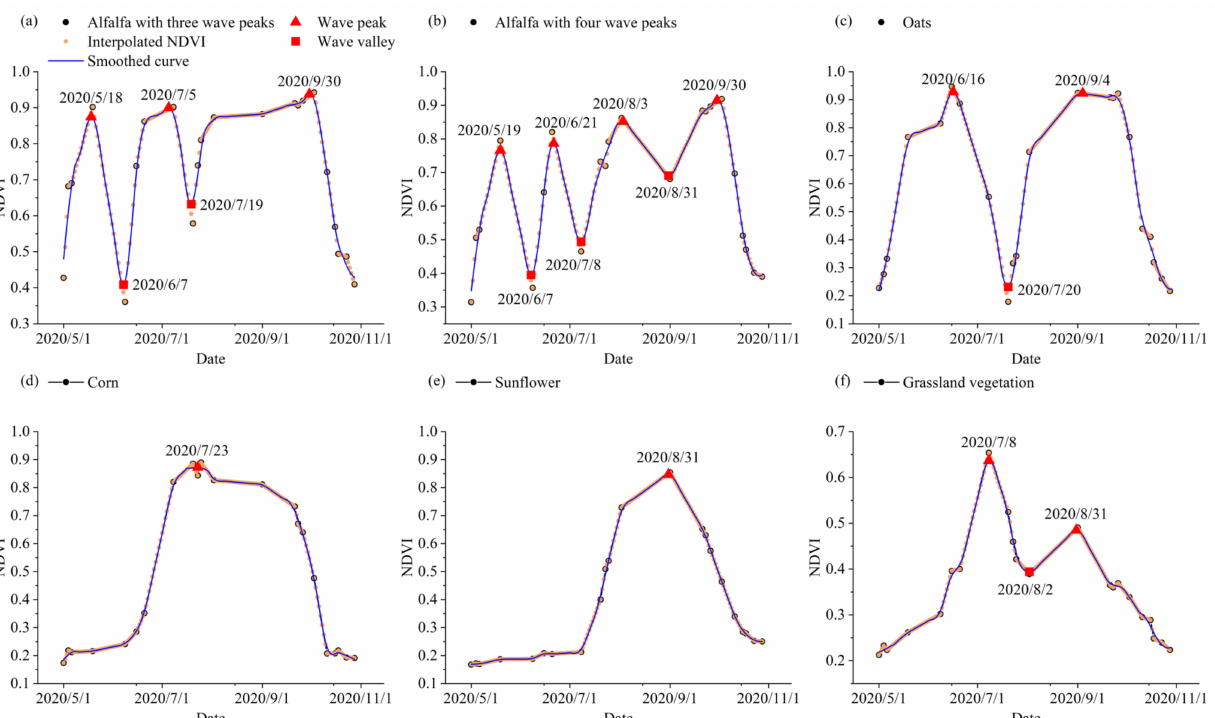
Figure 5. Interpolated, smoothing, wave peak and valley identification characteristics of the NDVI series of different vegetation types derived from the Sentinel-2 data.